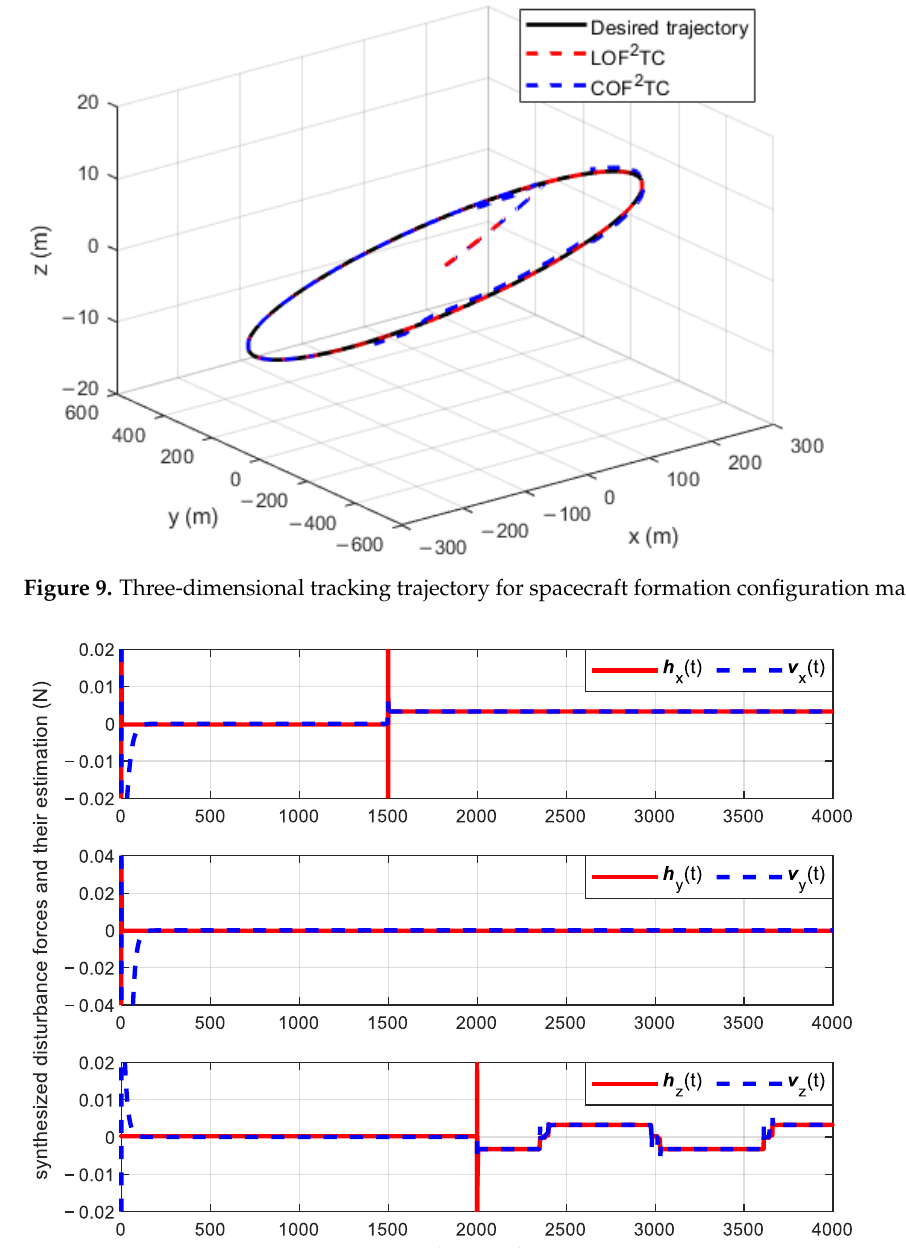
Figure 10. The estimation signal of the synthesized